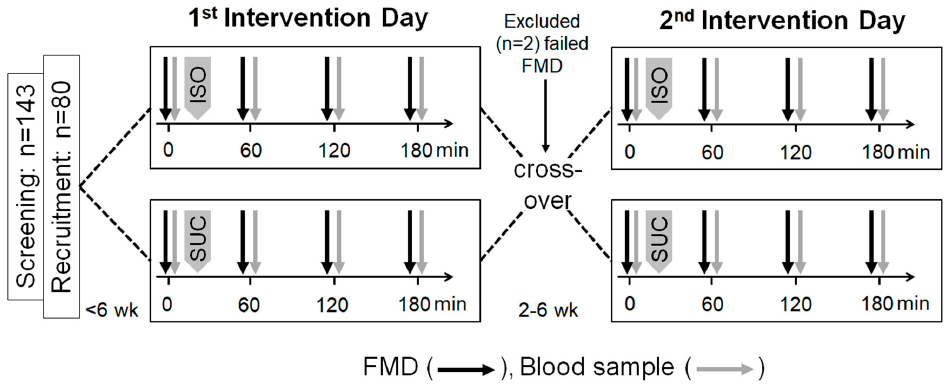
Figure 1. Outline of the study protocol. FMD, flow-mediated dilation; ISO, citrus drink containing 50 g of isomaltulose; SUC, citrus drink containing 50 g of